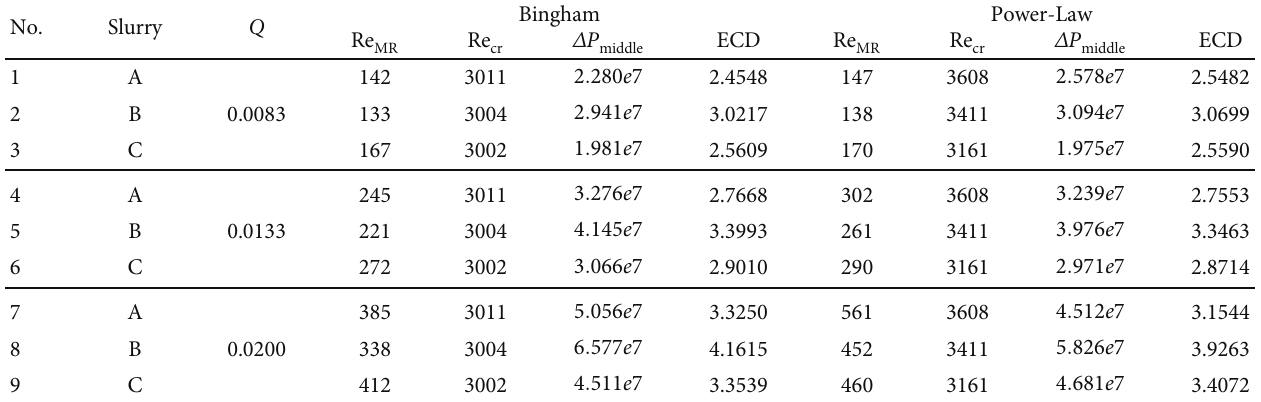
Table 6: ECD calculations using the DNS method for an annulus with varied radial sizes.